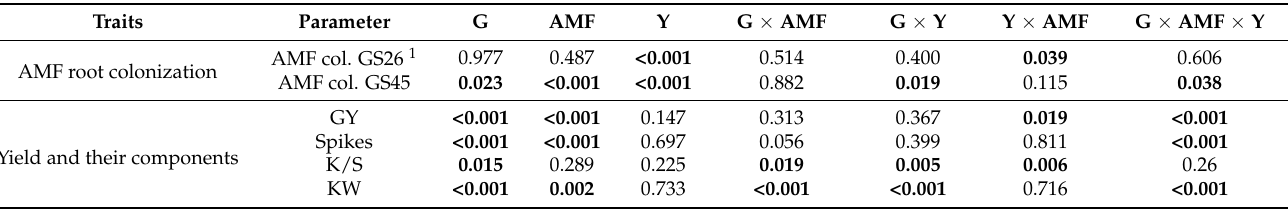
Figure 2. Effect of the interaction between arbuscular mycorrhizal fungal inoculation (AMF) and year of cultivation (Y) (AMF × Y) on the arbuscular mycorrhizal (AM) fungal root colonization of seven wheat genotypes sampled at the end of tillering (GS26) ( A ). Effect of the interaction among wheat genotype (G) × AMF × Y on the AM fungal root colonization of wheat samples at the booting growth stage (GS45) ( B ). ‐ M: mock ‐ AM fungal inoculated treatment (control); +M: AM fungal inoculated treatment. Wheat genotypes: G1: Gentil Rosso; G2: Risciola; G3: Frassineto; G4: Autonomia B; G5: Verna; G6: Blasco; G7: Bologna. Data are mean ± SE. Different letters indicate significant differences at P < 5% according to Tukey B test. Table 2. P -values of three-way ANOVA on the effect of genotype (G), arbuscular mycorrhizal fungal inoculation (AMF), and year of cultivation (Y) and their interactions on AMF root colonization (AMF col.) at the end of tillering and at booting growth stages (GS26 and GS45, respectively) and on the investigated wheat agronomic and quality parameters. In bold are statistically significant P values according to the post-hoc Tukey B test.